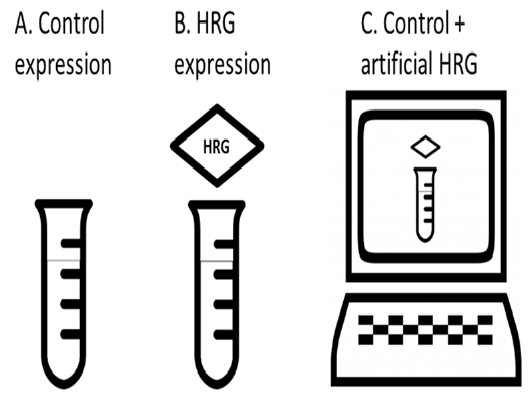
Figure 3. Schematic illustration of BioNSi simulations performed. Expression data from GSE6462 experiment was obtained for Control MCF7 breast cancer cells, without ( A ) or with ( B ) HRG treatment. ( C ) BioNSi simulation of artificial HRG effect performed on control